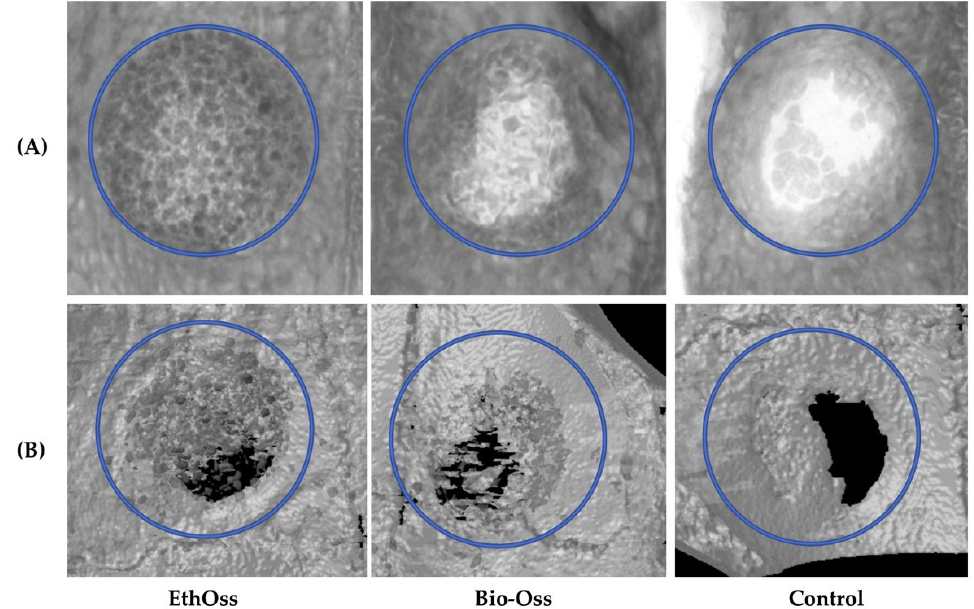
Figure 3. ( A ) Axial sections and ( B ) reconstructed three-dimensional (3D) micro-computed tomography (CT) images of the 8-mm-diameter defect sites after eight weeks of healing.